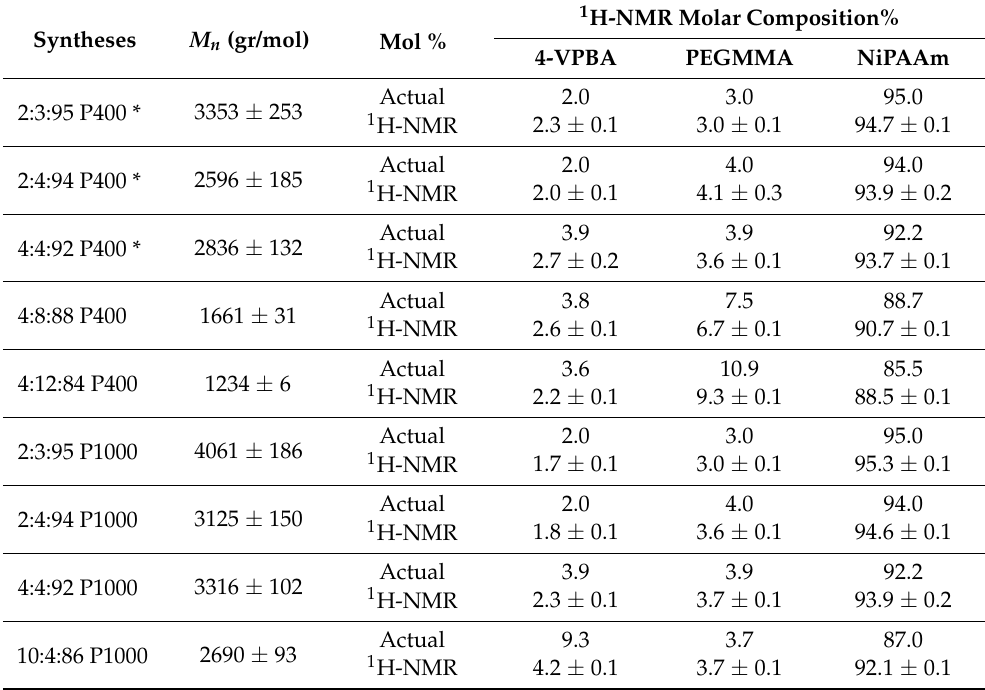
Table 2. Average results and standard error of the means (SEM) of number average molecular weight ( M n ) obtained from 1 H-NMR spectra. The size of the samples was n = 6 unless otherwise